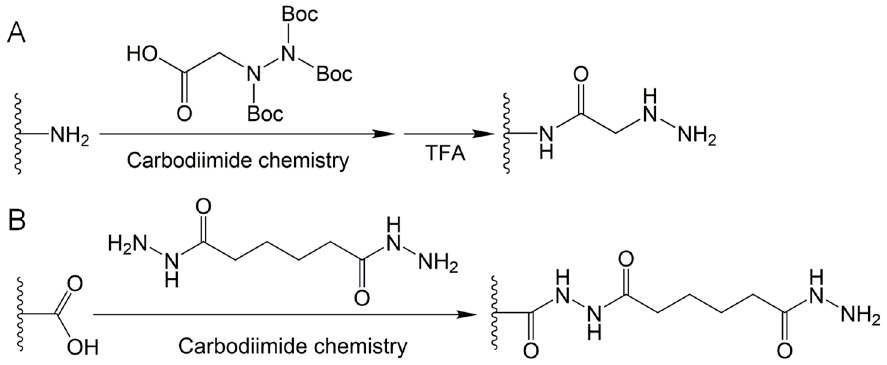
Figure 4. ( A ) Synthesis of hydrazide-functionalized polymer using carbodiimide chemistry coupling with tri-Boc-hydrazinoacetic acid for amide formation, and subsequent trifluoroacetic acid (TFA) deprotection of tert -butoxycarbonyl (Boc) groups. ( B ) Synthesis of acylhydrazide-functionalized polymer using carbodiimide chemistry coupling with dihydrazide-containing compounds, for example, adipoyldihydrazide coupling with a carboxyl group by amide formation.